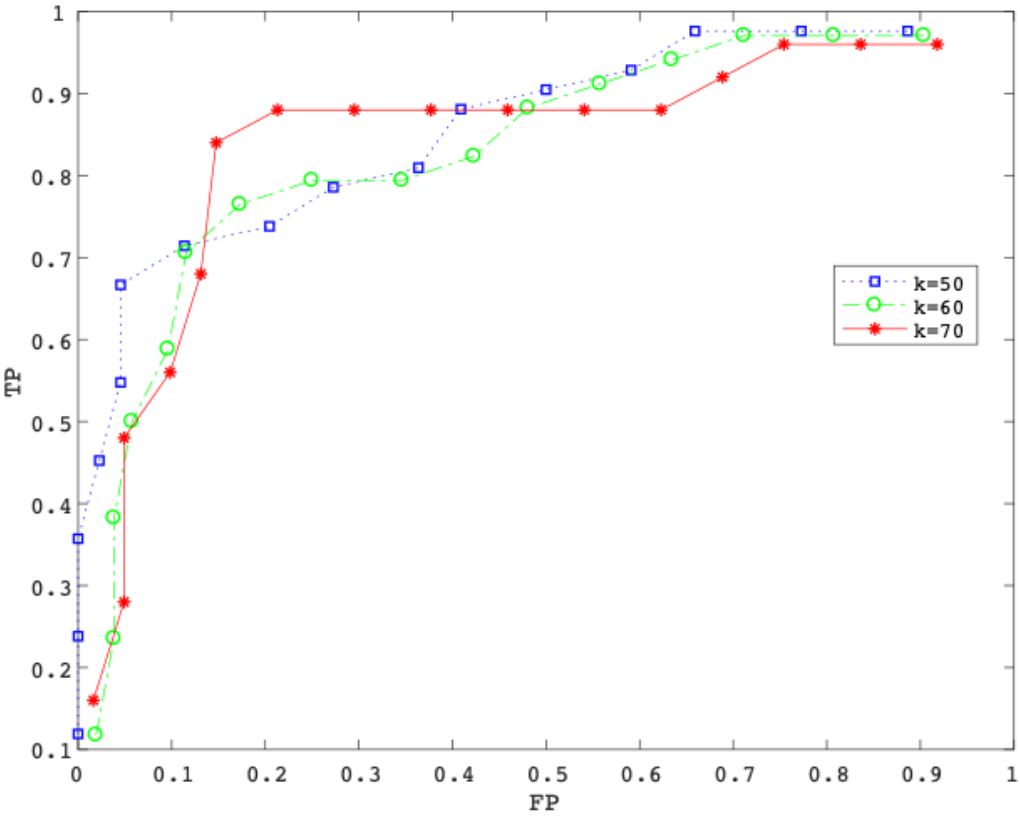
Figure 6. Receiver operating characteristic curves of unhealthy meal detection. The horizontal axis is the false positive rate (FP) and the vertical axis is the true positive rate (TP). Each curve shows the set of values of TP vs FP, when the definition of an unhealthy meal is a meal whose rank is lower than k% (k=50, 60, 70) of all